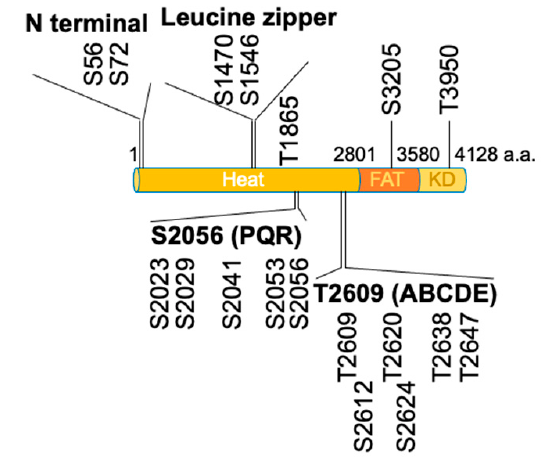
Figure 2. DNA-PKcs consists of the HEAT domain, FAT domain and kinase domain (KD). There are four autophosphorylation clusters (N terminal, leucine zipper, S2056/PQR and T2609/ABCDE) and one autophosphorylation site in the HEAT domain. There is an autophosphorylation site in the FAT (S3205) and KD (T3950) domains, respectively.